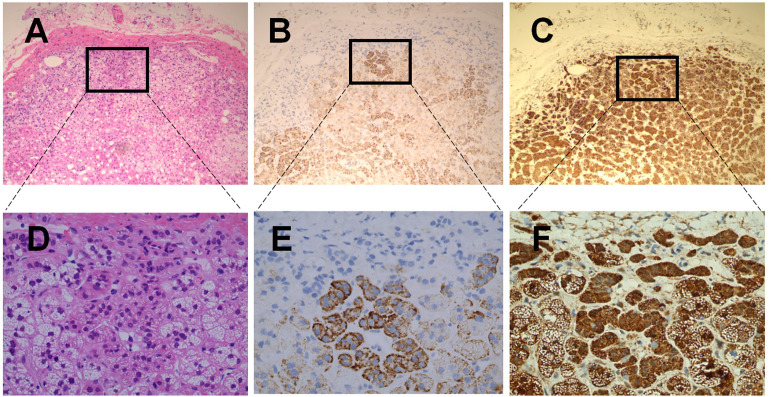
Haematoxilin-Eosin staining and immunohistochemical staining of ACE2 & TMPSS2 in human healthy adrenal tissues. (A–C) were the serial sections of the same adrenal cortex. Panel A showed Haematoxilin-Eosin (HE) staining. (B, C) were stained with antibodies aganist ACE2 (B) and TMPSS2 (C), respectively. Original magnification: ×100. Areas in black boxes in (A–C) were shown enlarged in (D–F) (×400), respectively.